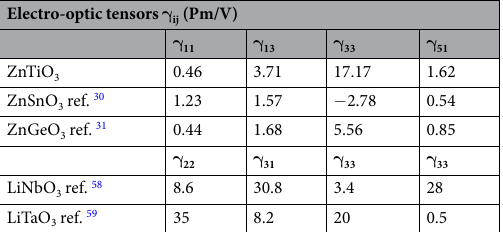
Table 10. The calculated Electro-optic tensor of LN-type ZnTiO 3